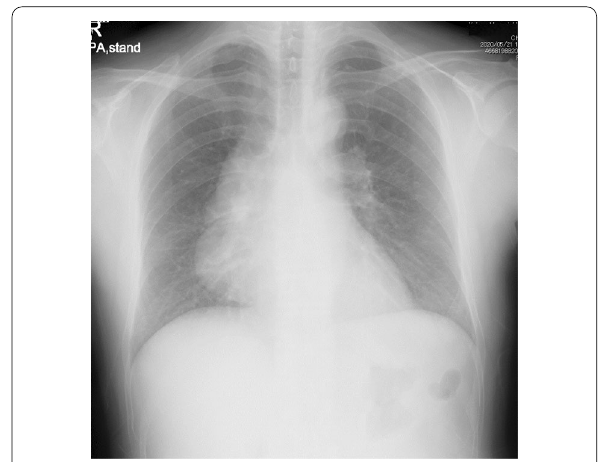
Fig. 1 Preoperative chest X-ray showed an abnormal mass in the right pericardial region